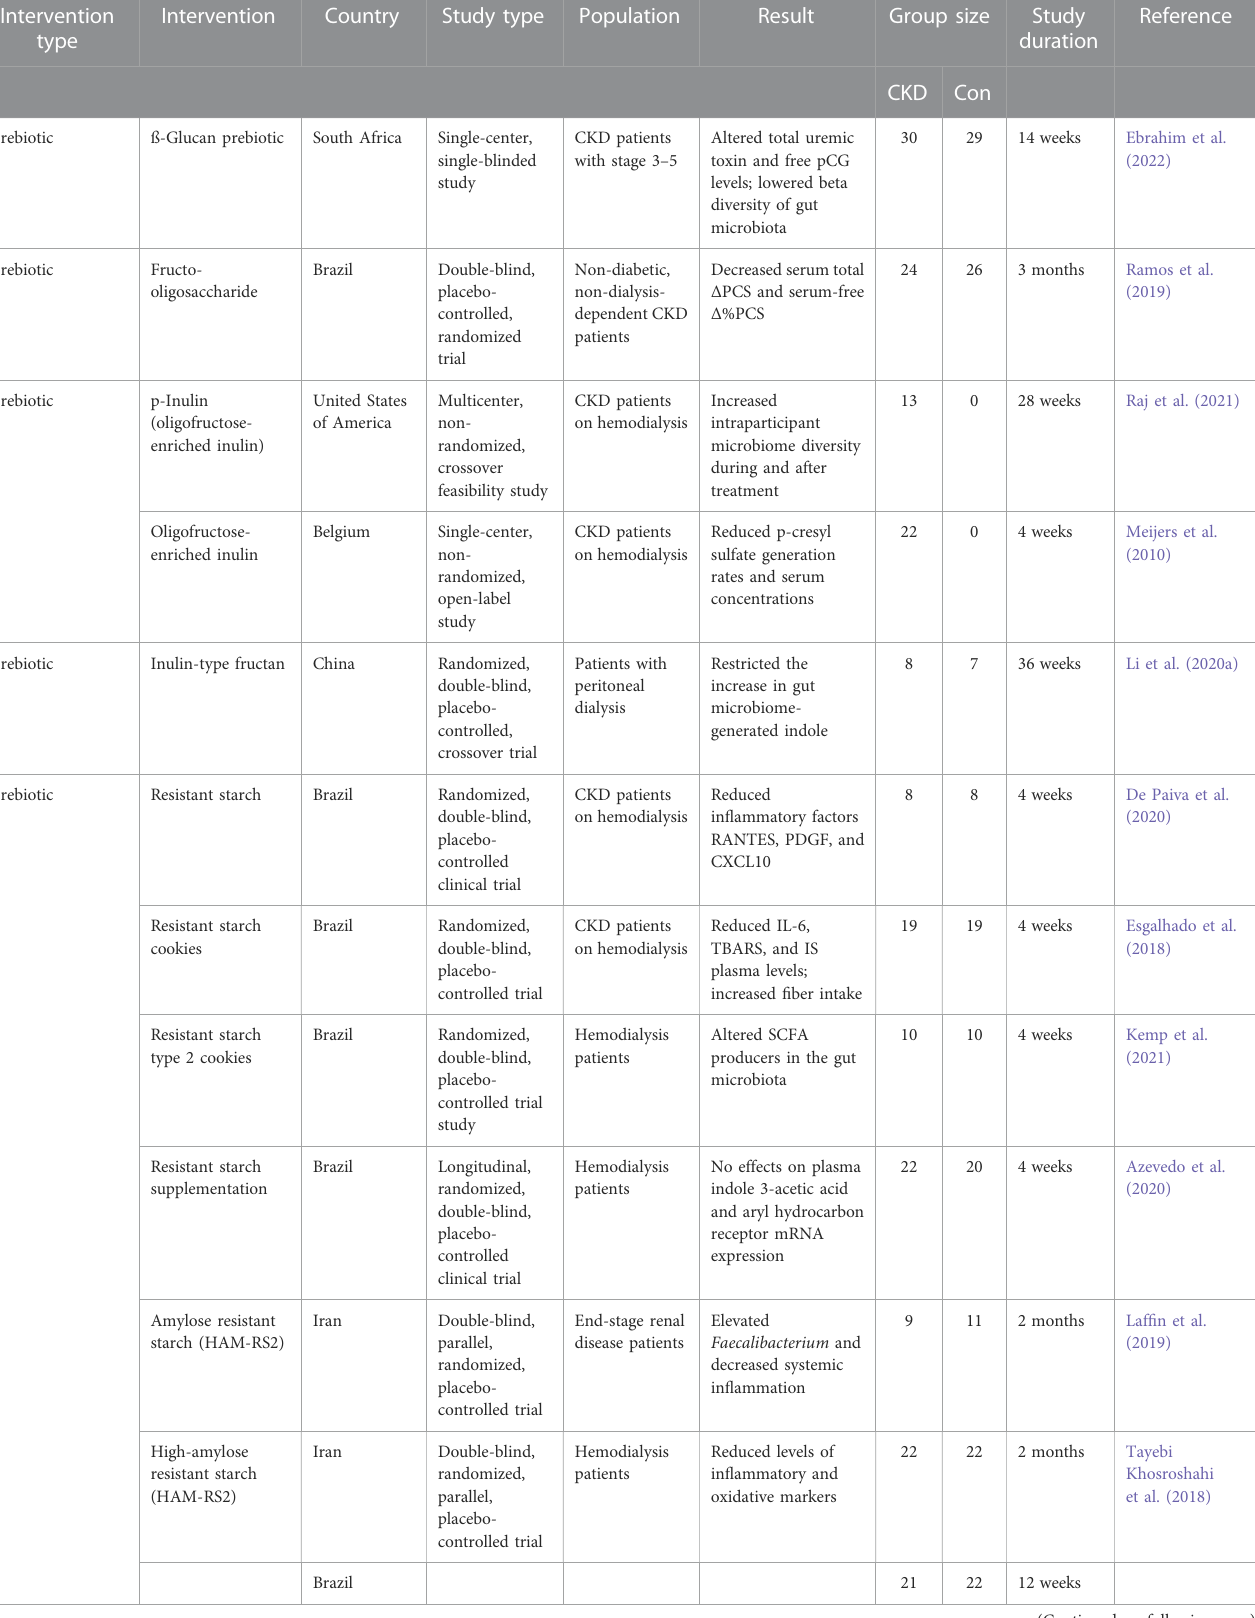
TABLE 2 Clinical trial of natural products from plants and microorganisms in the treatment of CKD patients by modulating gut microbiota. Intervention type